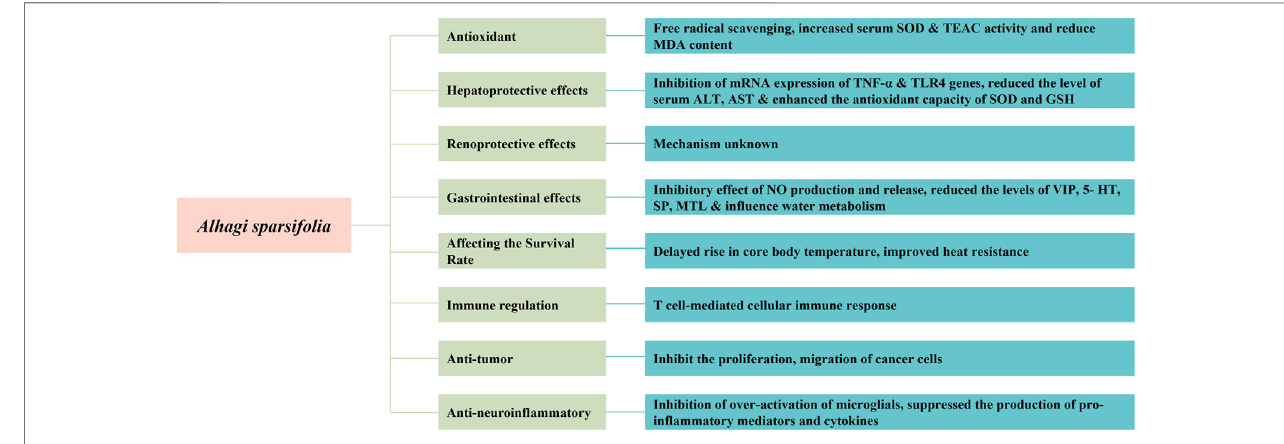
FIGURE 10 | Possible mechanisms for pharmacological